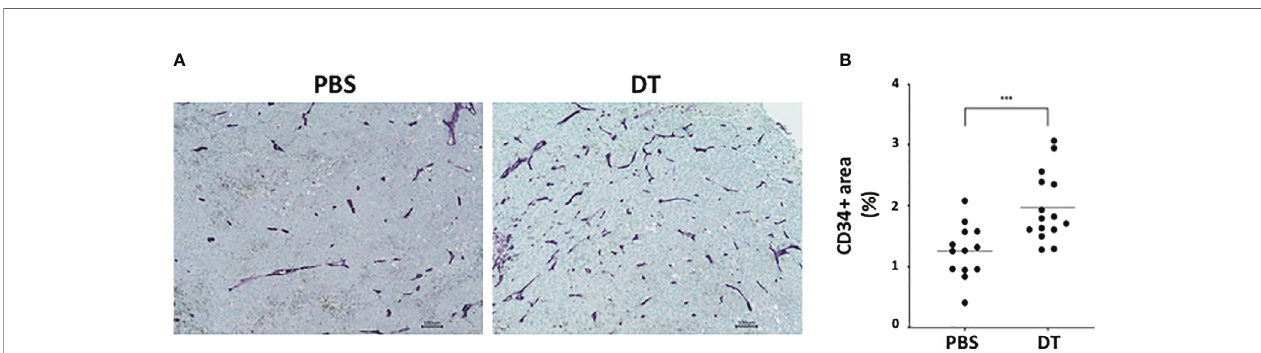
FIGURE 3 | Depletion of L2pB1 cells increases angiogenesis in melanoma. CD34 expression in (A) PBS-injected control and DT-injected B16F10 melanoma tumors assessed by immunohistochemistry. (B) Angiogenesis was quanti fi ed as the ratio of total CD34-positive areas (purple) to the total tumor tissue area. ***P = 0.0009. Data are pooled from three independent